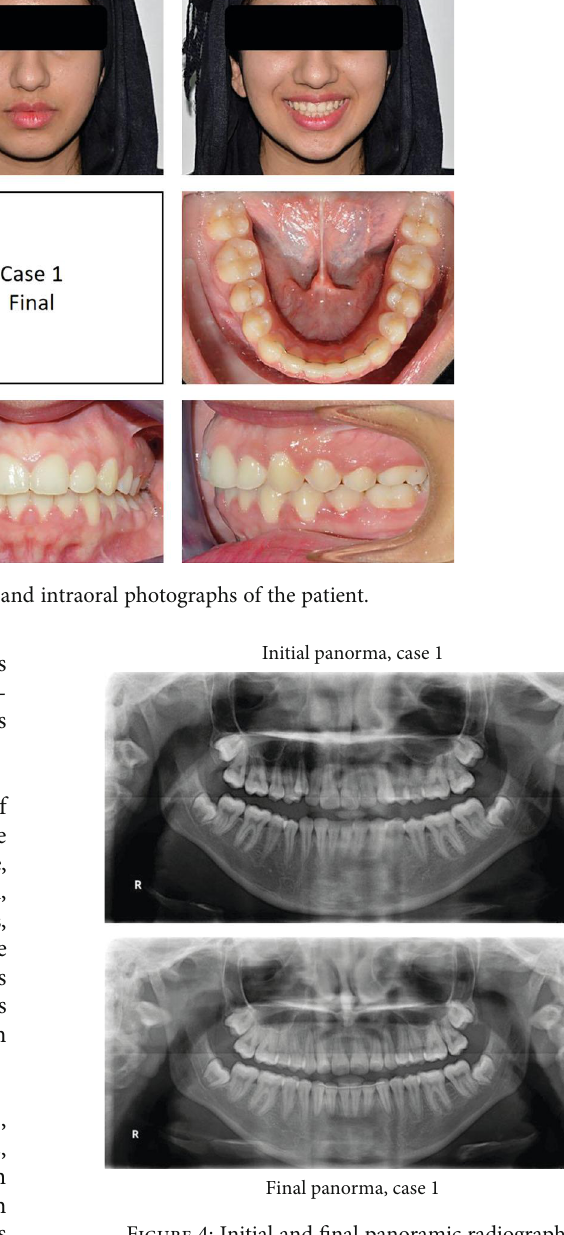
Figure 4: Initial and fi nal panoramic